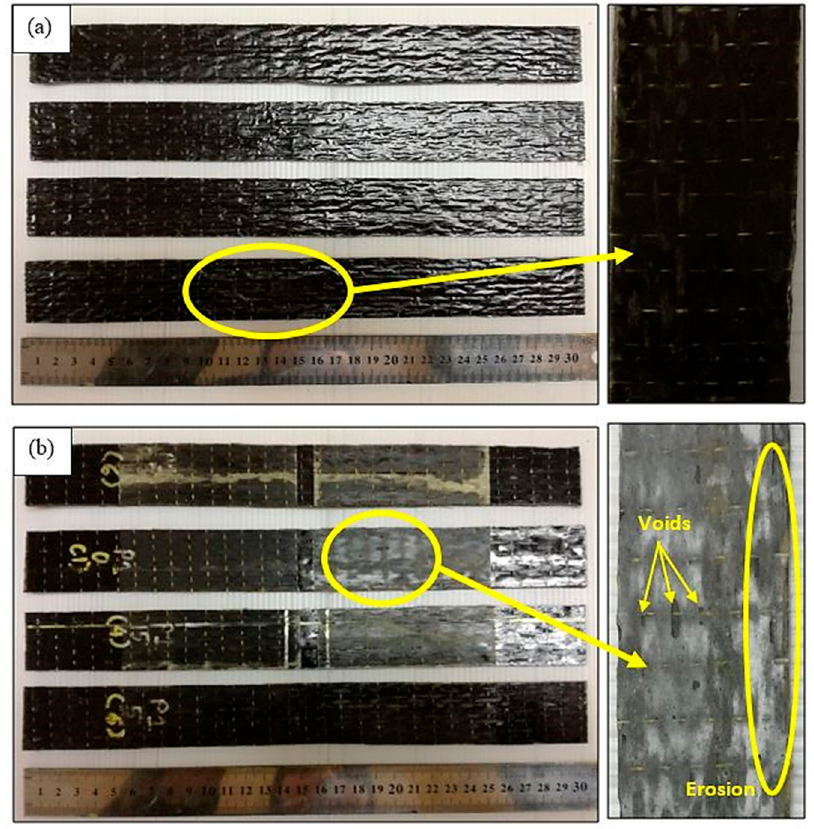
Figure 5. Overall surface of unmodified BFRP composites ( a ) unconditioned, ( b ) conditioned specimens.